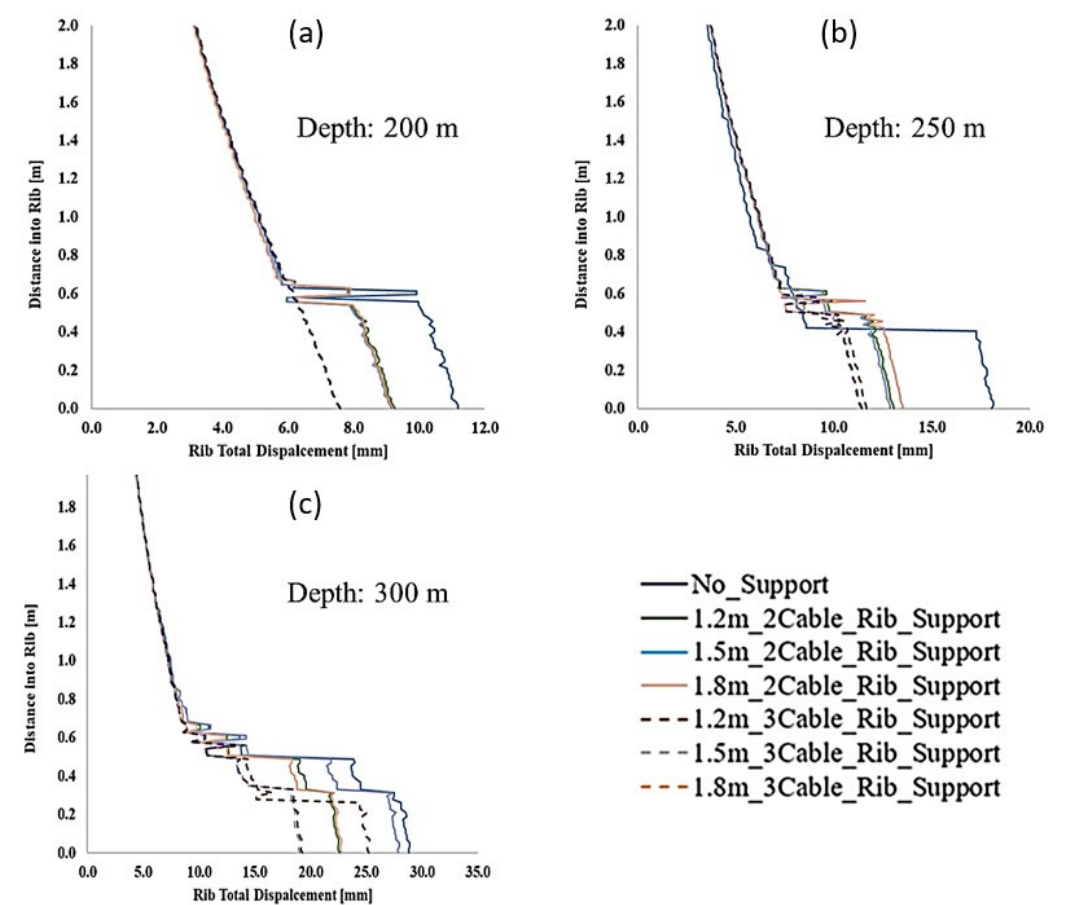
Figure 16. The simulated effect of cable rock bolting on mine rib deformation. ( a ) at depth 200 m, ( b ) at depth 250 m, ( c ) at depth 300 m.